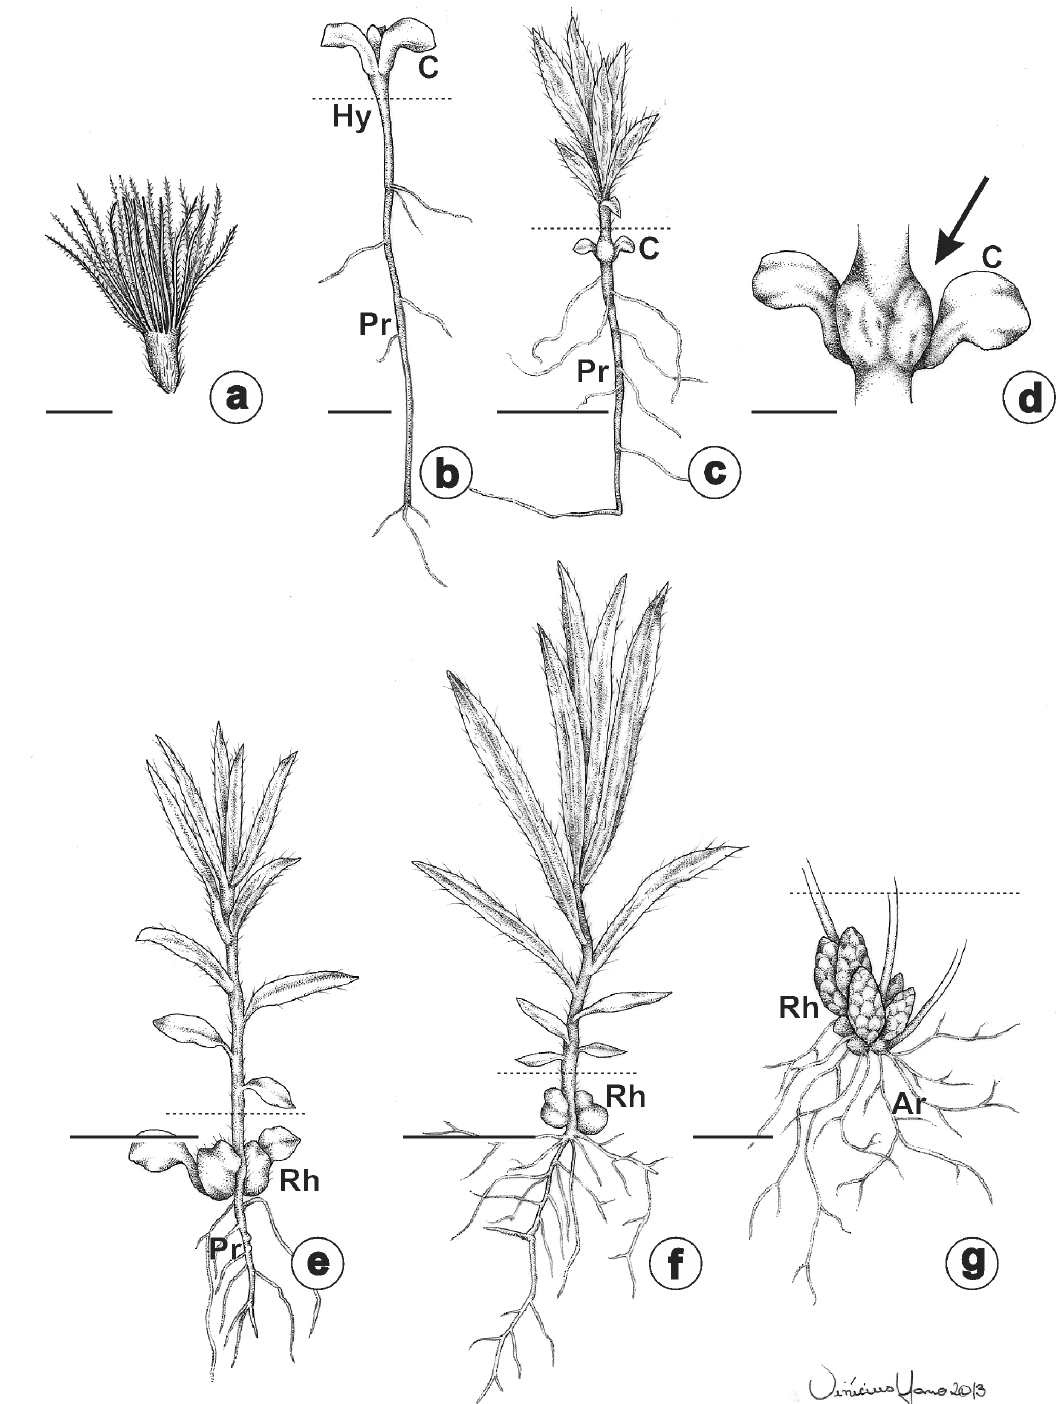
Figure 2 - Developmental stages of Chrysolaena simplex. (a) General view of the cypsela. (b) Fifteen-day-old individual. (c, d) Two-and-a-half-month-old individual. (c) General view. (d) Cotyledonary node; arrow points to rhizophore formation. (e) Three-month-old individual. (f) Four-month-old individual. (g) Adult individual. Ar: adventitious roots; C: cotyledons; Hy: hypocotyl; Pr: Primary root; Rh: rhizophore; Dashed line: Soil level. Scale bars, 2.5 mm (a) ; 3 mm (b) ; 9 mm (c) ; 1 mm (d) ; 1.5 cm (e, g) ; 2.5 cm (f) . See the colors in the online